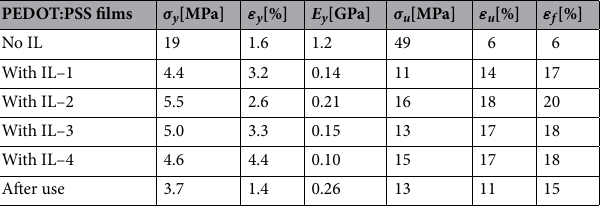
Table 2. Stress and strain values of the PEDOT:PSS films, extracted from Fig.